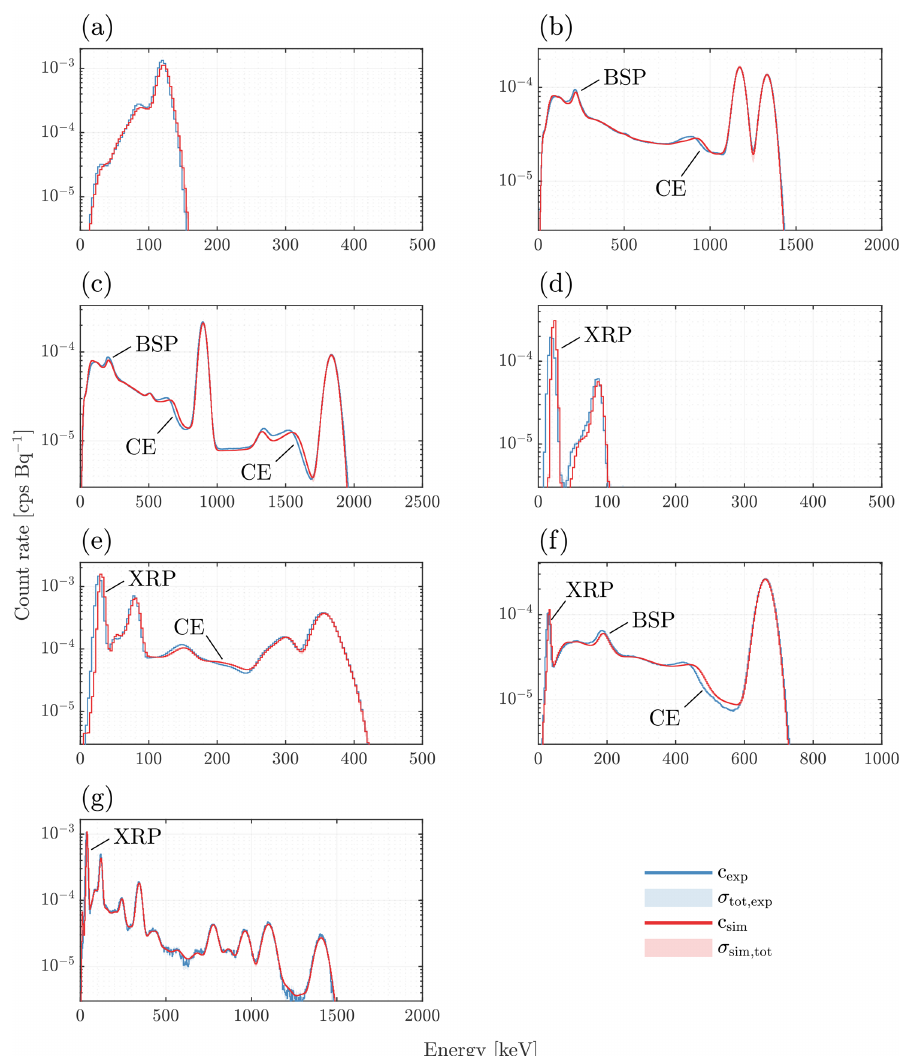
Figure 3. Spectral comparison of the experimental and simulated detector response for different radiation sources using the summed scin- tillation crystal spectra. (a) 57 Co. (b) 60 Co. (c) 88 Y. (d) 109 Cd. (e) 133 Ba. (f) 137 Cs. (g) 152 Eu. Uncertainties are provided as 1SD values ( σ tot,exp , σ tot,sim ) for the experimental as well as the simulated spectra (only visible in Fig. 3b). Backscatter peaks (BSP), characteristic X -ray peaks (XRP) and Compton edges (CE) are highlighted.